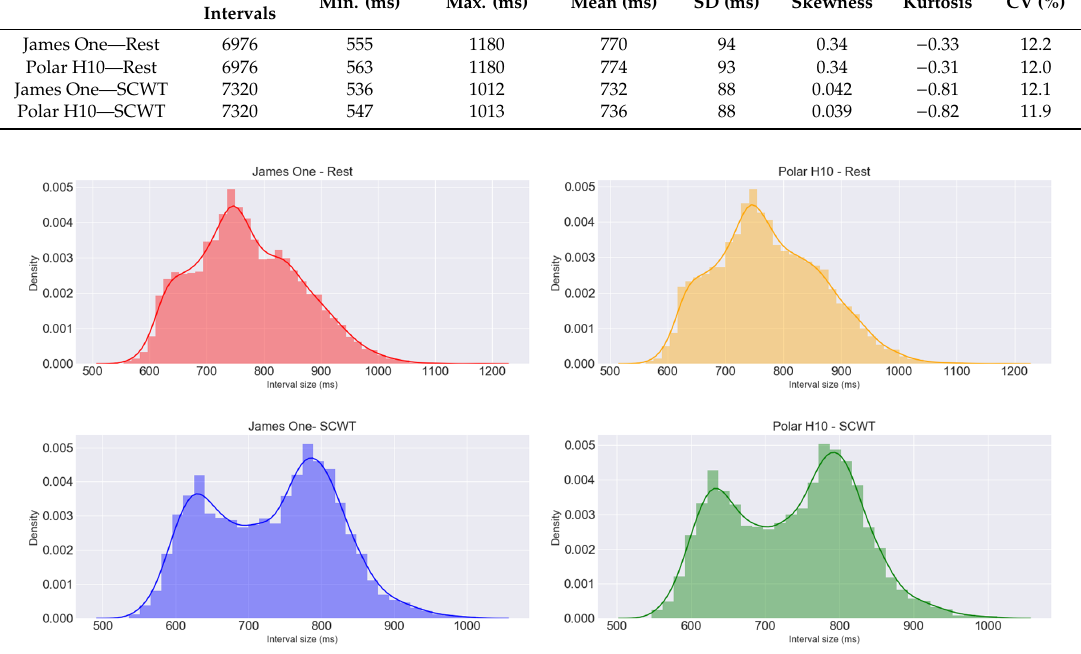
Figure 4. Histograms with a fitted kernel density estimation of the intervals obtained from the devices at rest and during the SCWT.